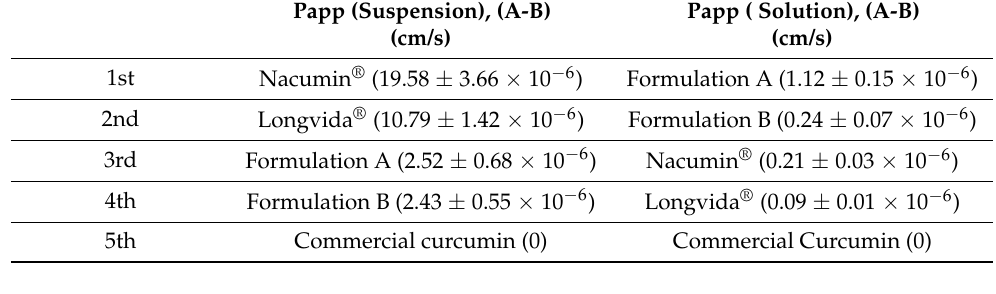
Table 7. Ranking of samples in terms of Papp (A-B) value (from high to low).